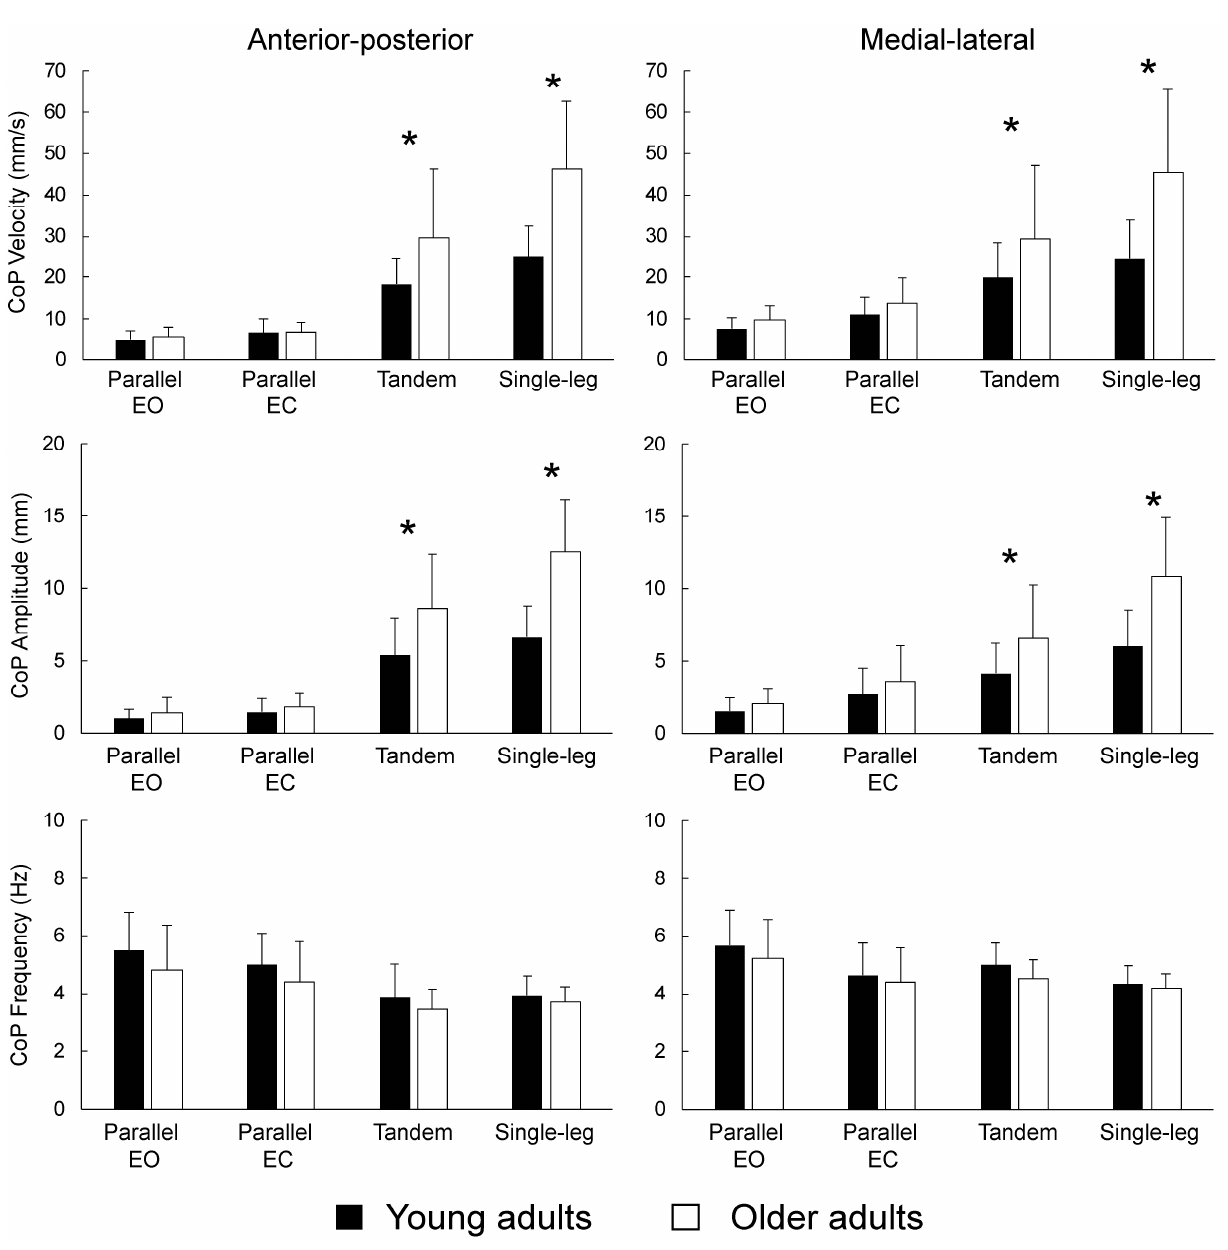
Figure 1. Comparison of whole-trial outcomes between young and older adults across tasks. CoP— center of pressure; AP—anterior–posterior; ML—medial–lateral; EO—eyes open; EC—eyes closed. * Indicates statistically significant difference between the young and older group ( p < 0.05).